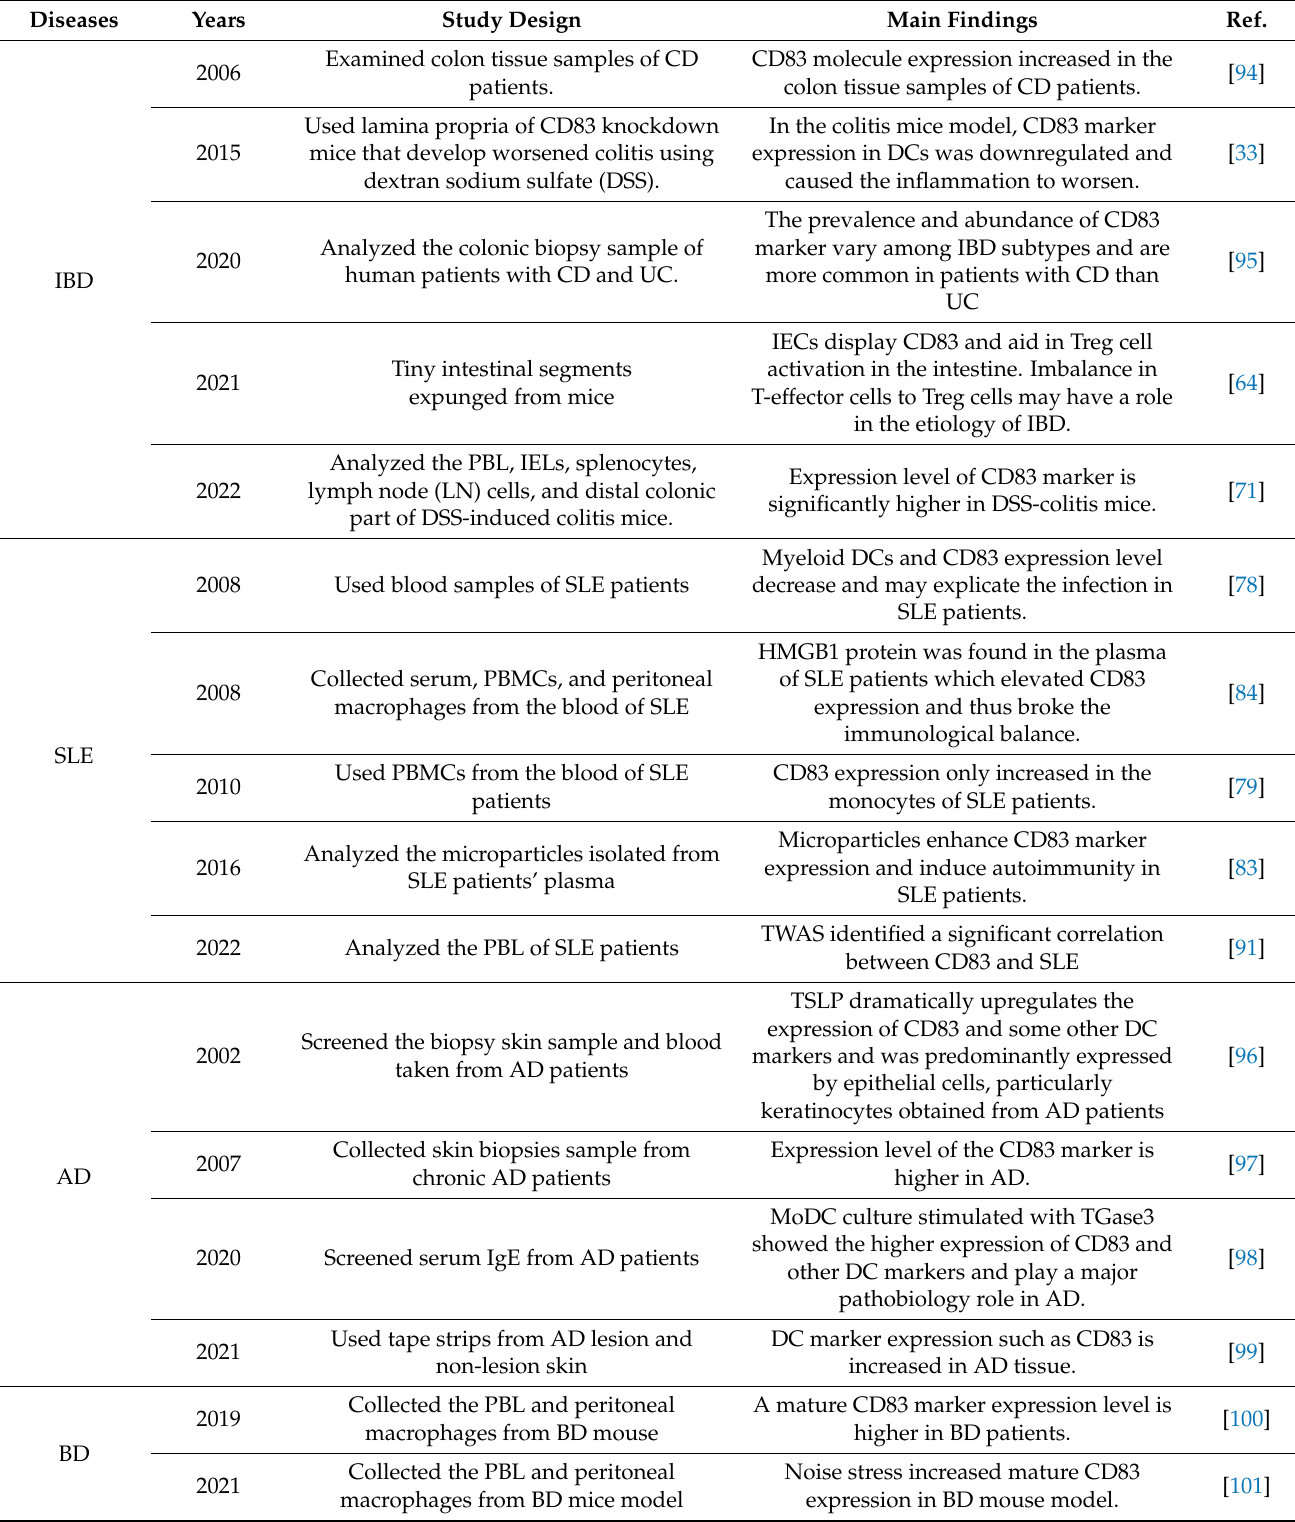
Table 1. Involvement of CD83 in inflammatory